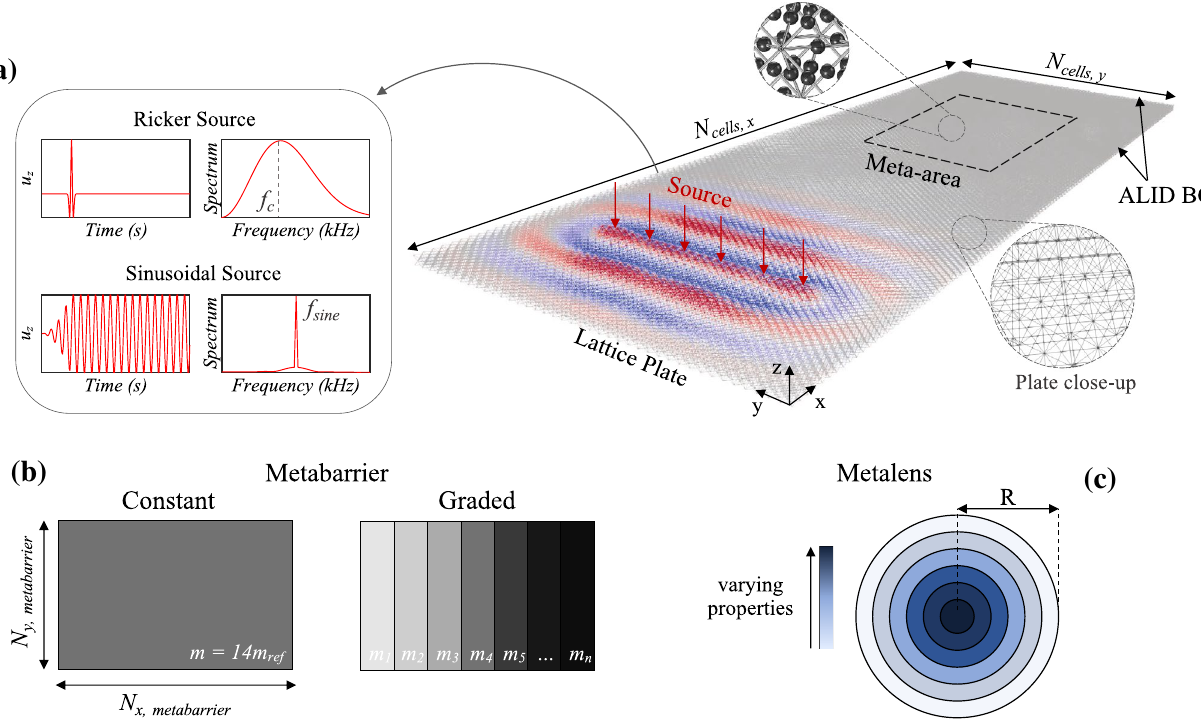
Figure 3. Setup for time-transient simulations in Real-ESSI. ( a ) Lattice plate made of standard octet units as detailed by the close-up. The meta-area (dashed black line) consists of embedded-mass octets arranged as rectangular metabarriers or circular metalenses, as reported in ( b ) and ( c ). Absorbing boundary conditions with quadratically increasing damping 60 (ALID) are implemented on all four edges of the plate. The two sources used for the metabarriers (Ricker) and metalenses (sine) are sketched in the inset. ( b ) Metabarries of customized cells with auxiliary masses. On the left side, the constant setup (